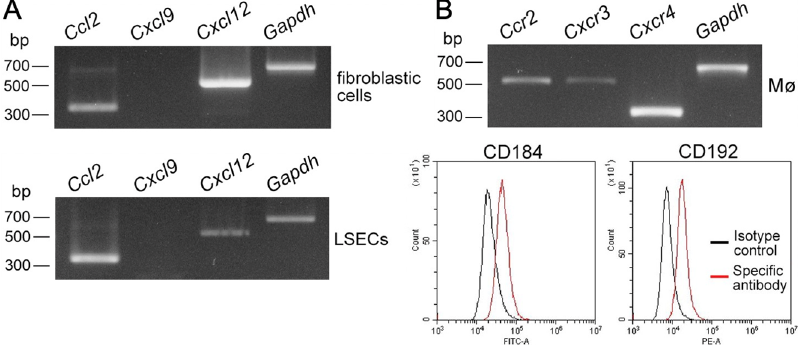
Figure 7. mRNA expression of chemokines in fibroblastic cells and LSECs, and cell surface expression of corresponding chemokine receptors in liver Mø propagated using mixed culture. ( A ) mRNA expression of chemokines (CCL2, CXCL9, CXCL12) in primary LSECs and propagated fibroblastic cells in mixed culture with liver Mø. Both cells clearly expressed Ccl2 and Cxcl12. ( B ) mRNA expres- sion of the corresponding chemokine receptors (CCR2, CXCR3, CXCR4) determined using RT-PCR and their cell surface expression (CD184, CXCR4; CD192, CCR2) determined using flow cytometry (red line histogram, specific antibody; black line histogram, isotype control) in propagated liver Mø in mixed culture. The propagated Mø expressed CD184 and CD192. Thus, liver Mø likely receive CCL2 and CXCL12 produced by LSECs and fibroblasts via CD192 and CD184, respectively.